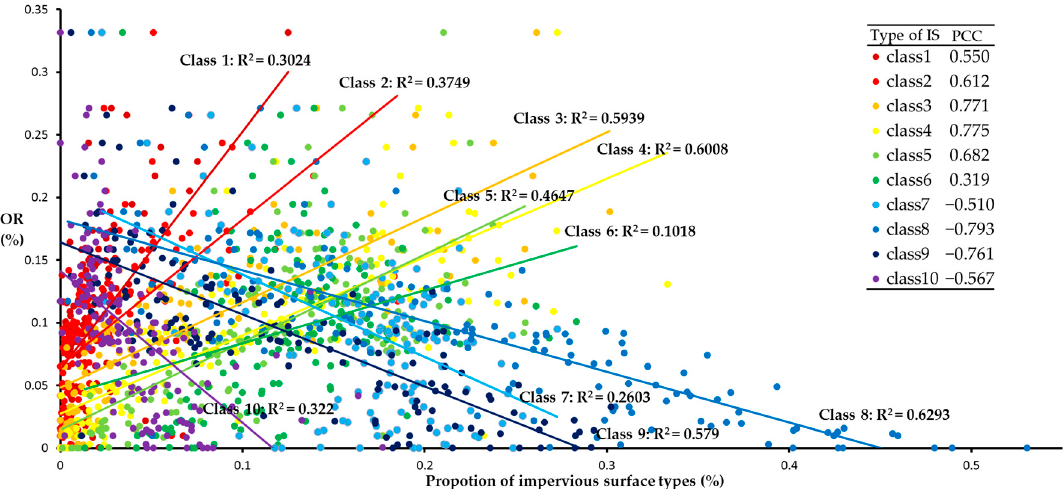
Figure 14. Regression modeling between optimization rate and proportion of impervious surface type. Abbreviations: IS, impervious surfaces; OR, odds ratio.